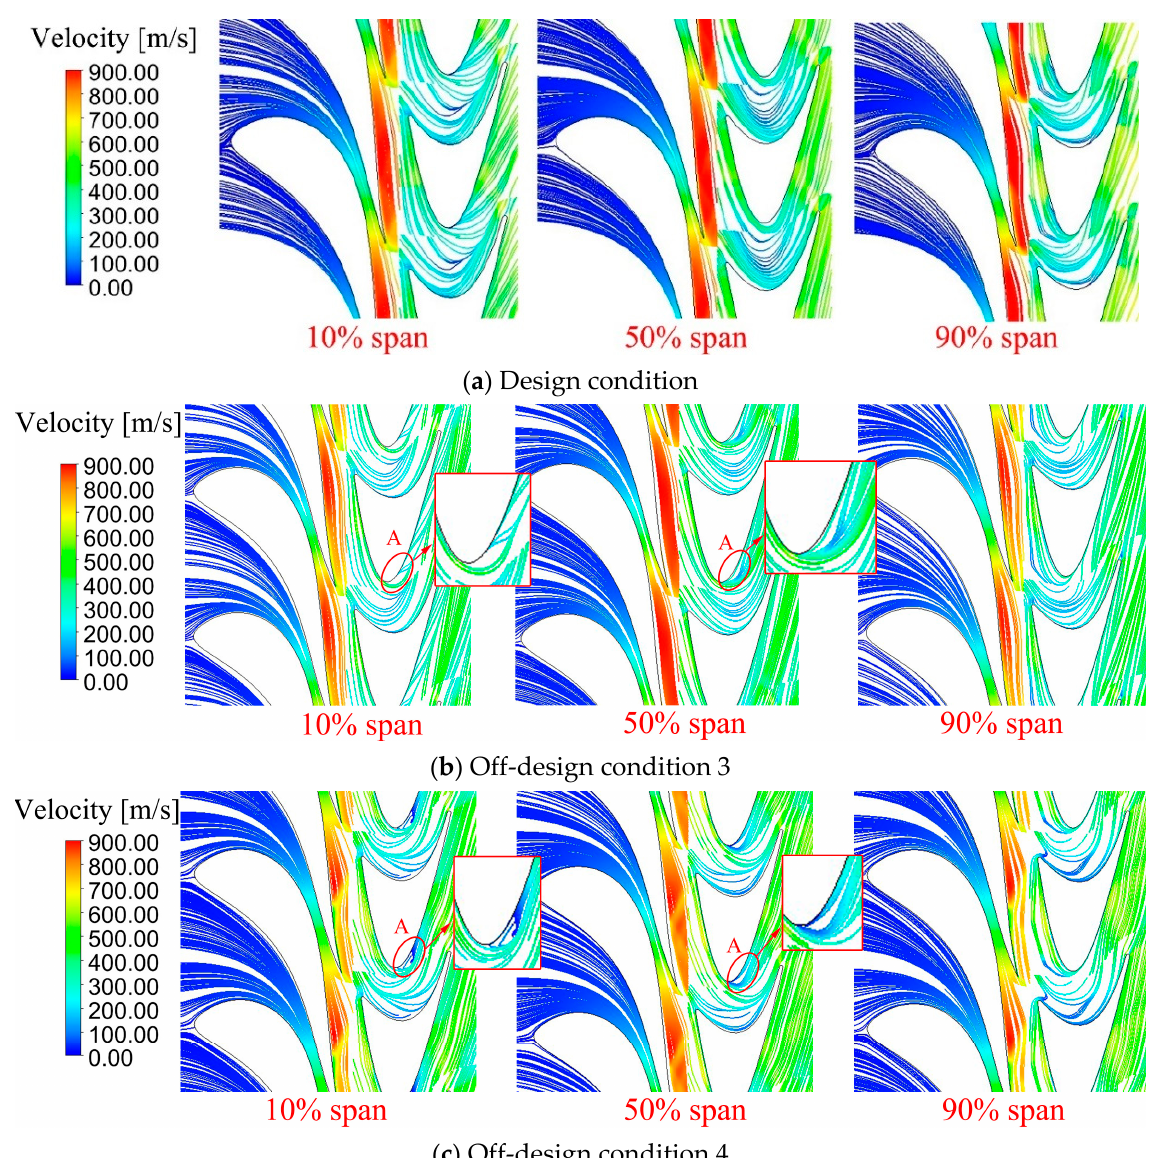
Figure 8. Streamline patterns of 50% span at design and off-design conditions.